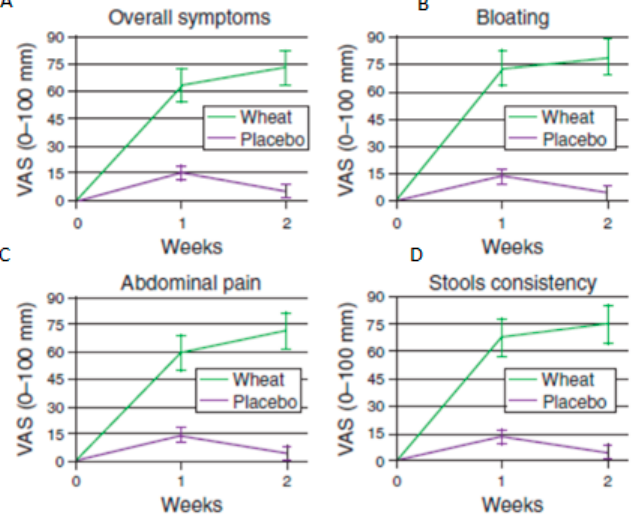
Figure 4. Response to double-blind, placebo-controlled wheat challenge in 270 wheat-sensitive non-celiac IBS patients from symmptom diary. Y axis shows symptom scores on a visual analog scale 0–100, where 0= no symptoms and 100 equals maximum symptoms for. ( A ) Overall symptoms, ( B ) Bloating, ( C ) Abdominal pain and ( D ) Stool consistency. Reproduced with permission of the editor from Carroccio et al. [114].